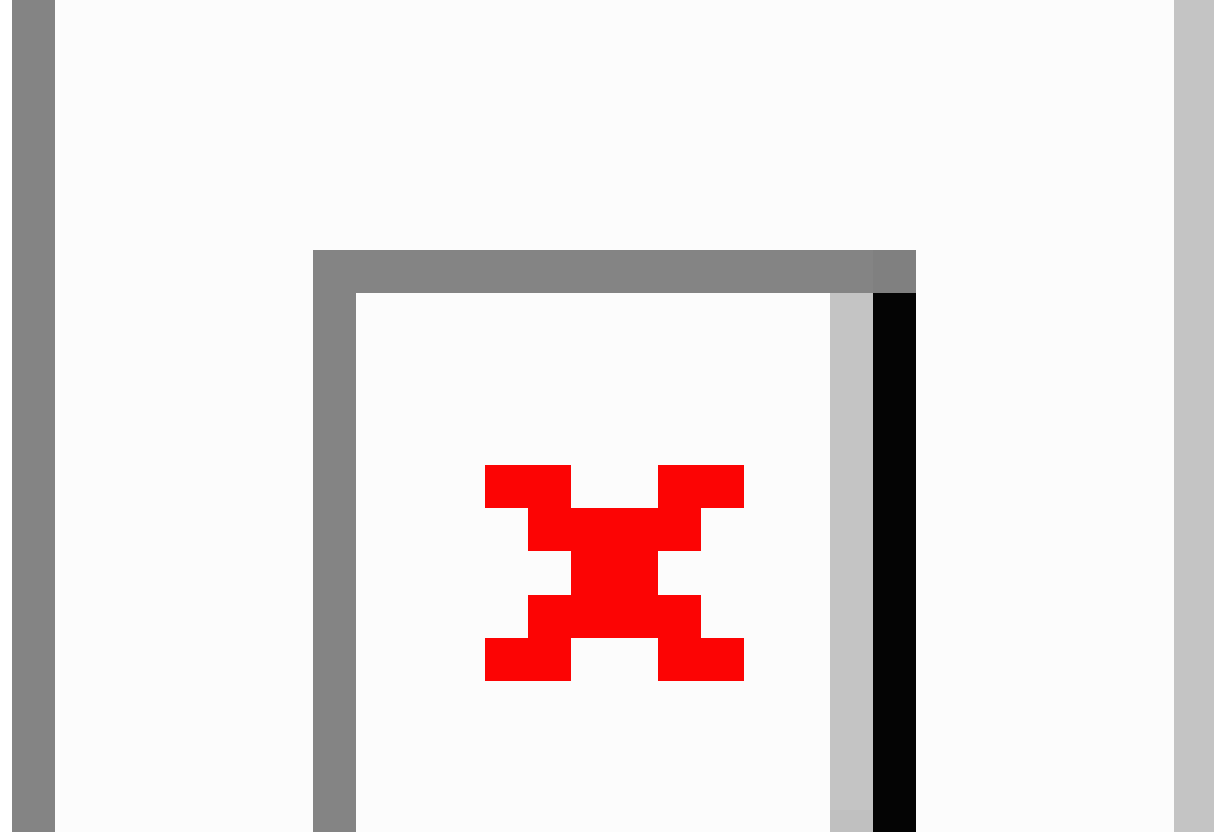
Figure 1. Breakdown of cohorts based on inclusion and exclusion criteria and separation into preperiod and postperiod